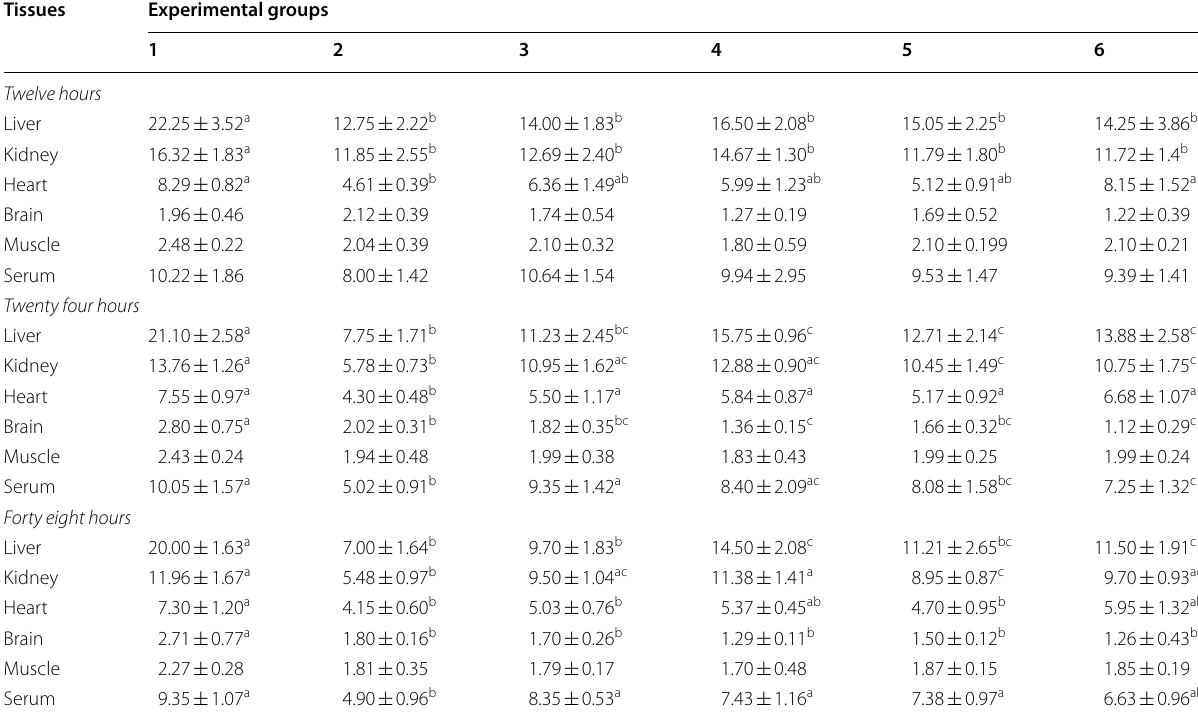
mg protein) Tissues Experimental